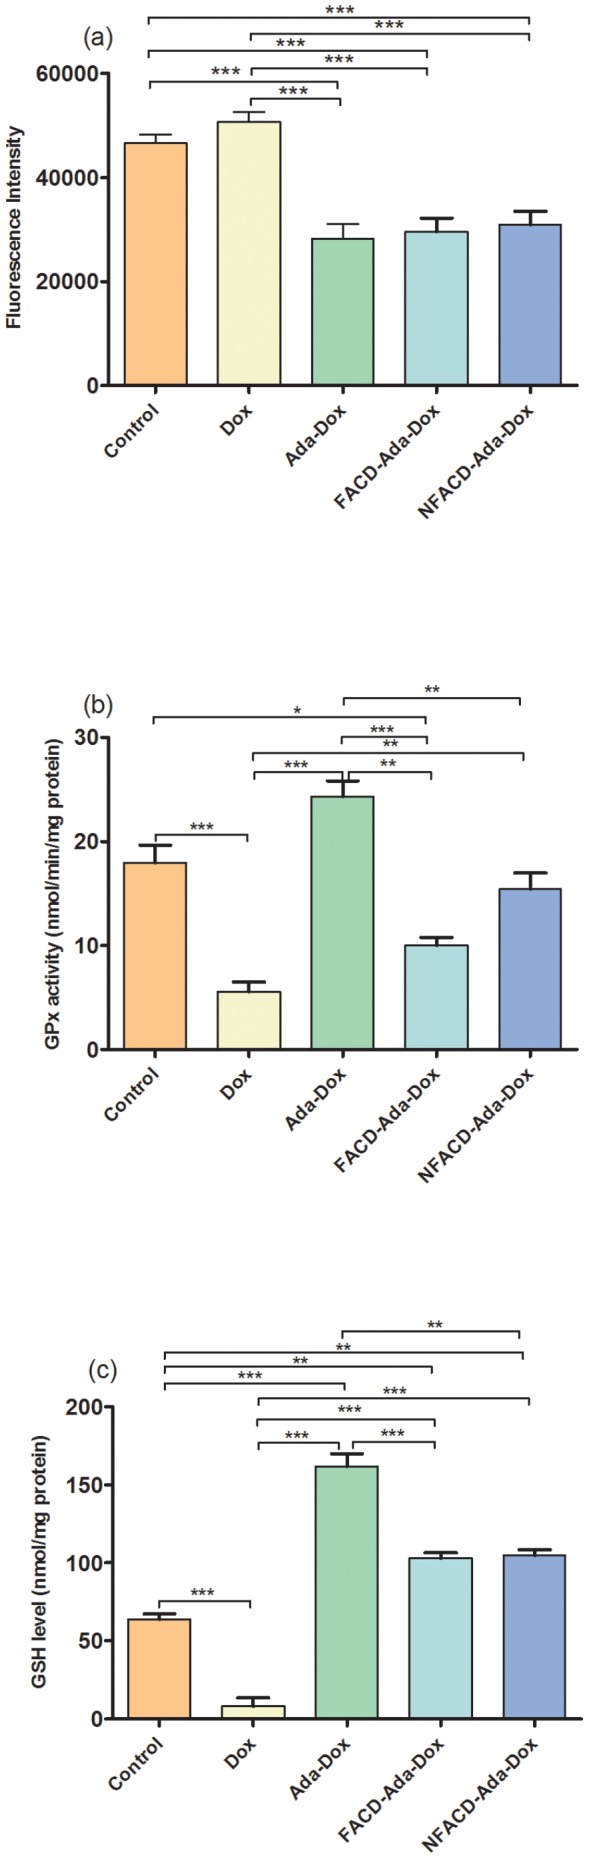
Determination of intraceullar ROS, GPx and GSH levels in mouse heart H9C2(2-1) cells.Plot a shows the level of intracellular ROS in H9C2(2-1) cells treated with Dox, Ada-Dox or FACD-Ada-Dox at 2.0 µM for 18vhr at 37°C in the culture media. Cells were treated with CM-H2DCFDA. Plot b displays the activity of GPx in H9C2(2-1) cells in the presence of Dox, Ada-Dox or FACD-Ada-Dox at 2.0 µM. Plot c shows the GSH concentrations (expressed as nmol/mg protein) in H9C2(2-1) cells in the presence of Dox, Ada-Dox or FACD-Ada-Dox at 2.0 µM. Values are the mean ± SD of three different homogenates of cells analyzed in triplicate. *
P<0.05; **
P<0.01; and ***
P<0.001.